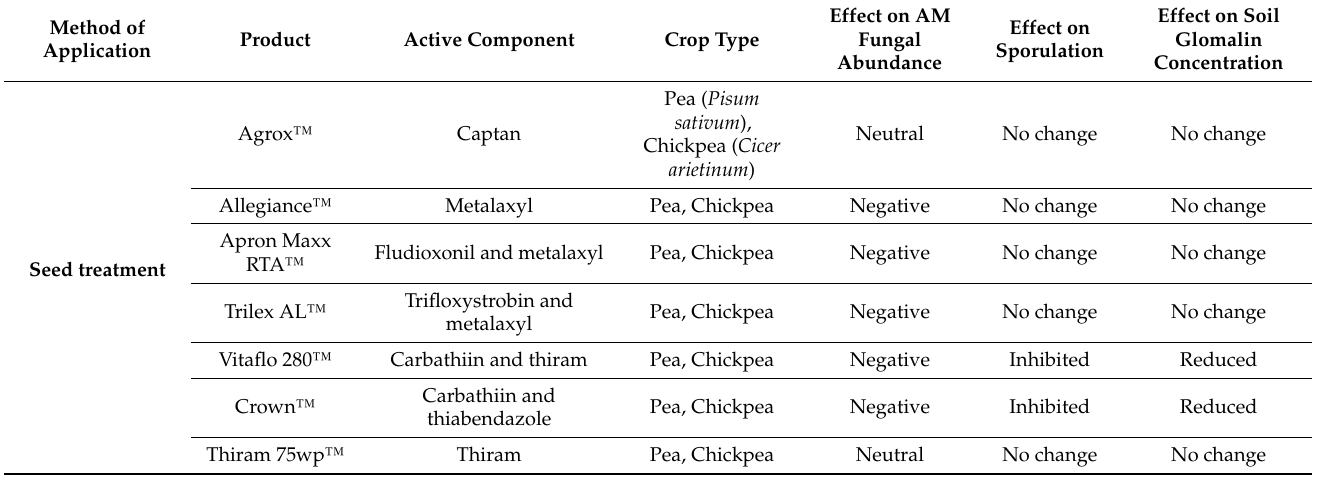
Table 2. The effects of fungicide active components on arbsuclar mycorrhizal (AM) fungal abundance in soil and the rhizosphere, the influence on sporulation, and the concentration of soil glomalin between three different methods of fungicide application and the crop to which applied